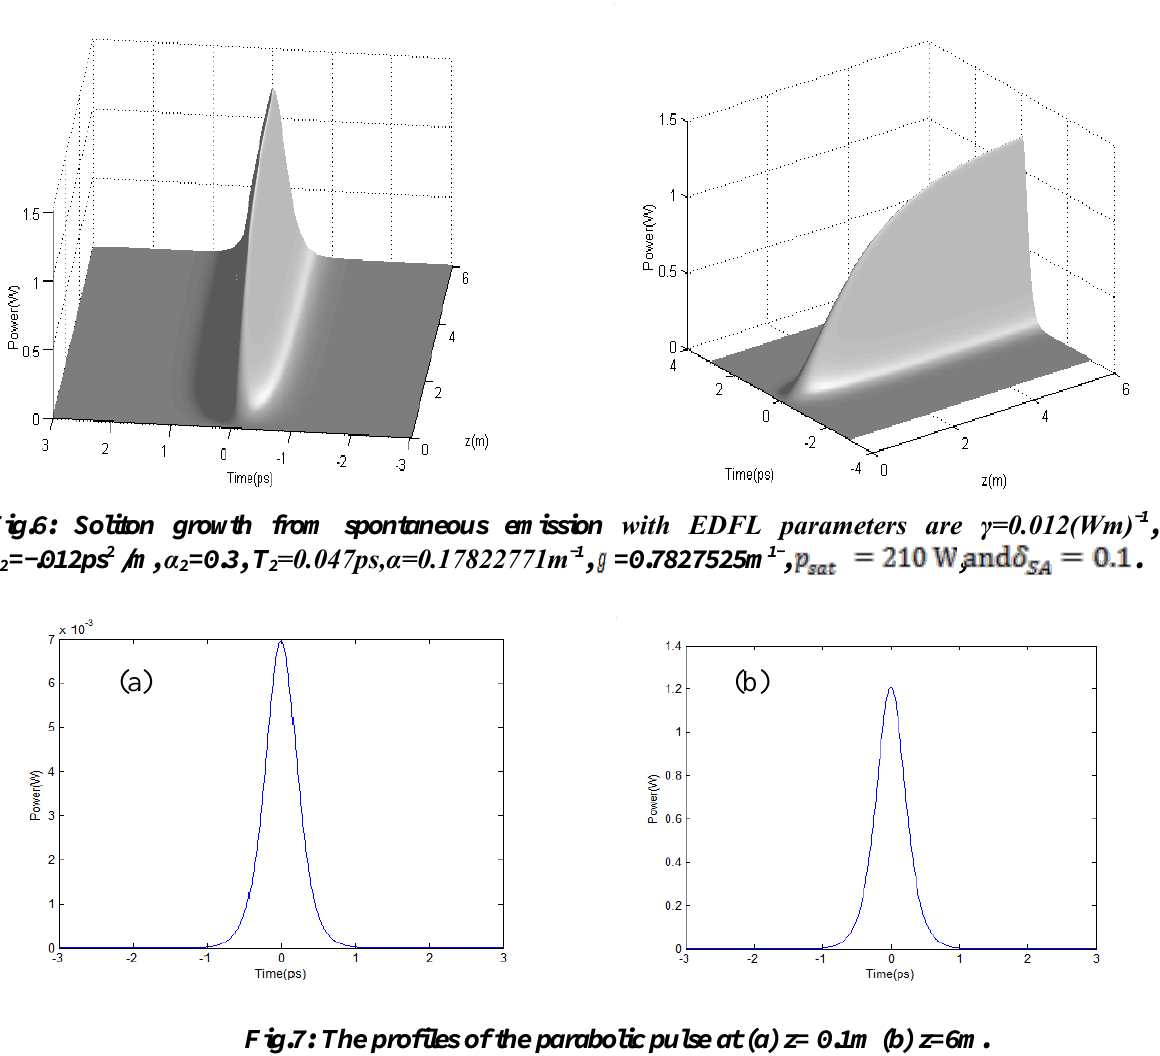
Fig.7: The profiles of the parabolic pulse at (a) z= 0.1m (b) z=6m.